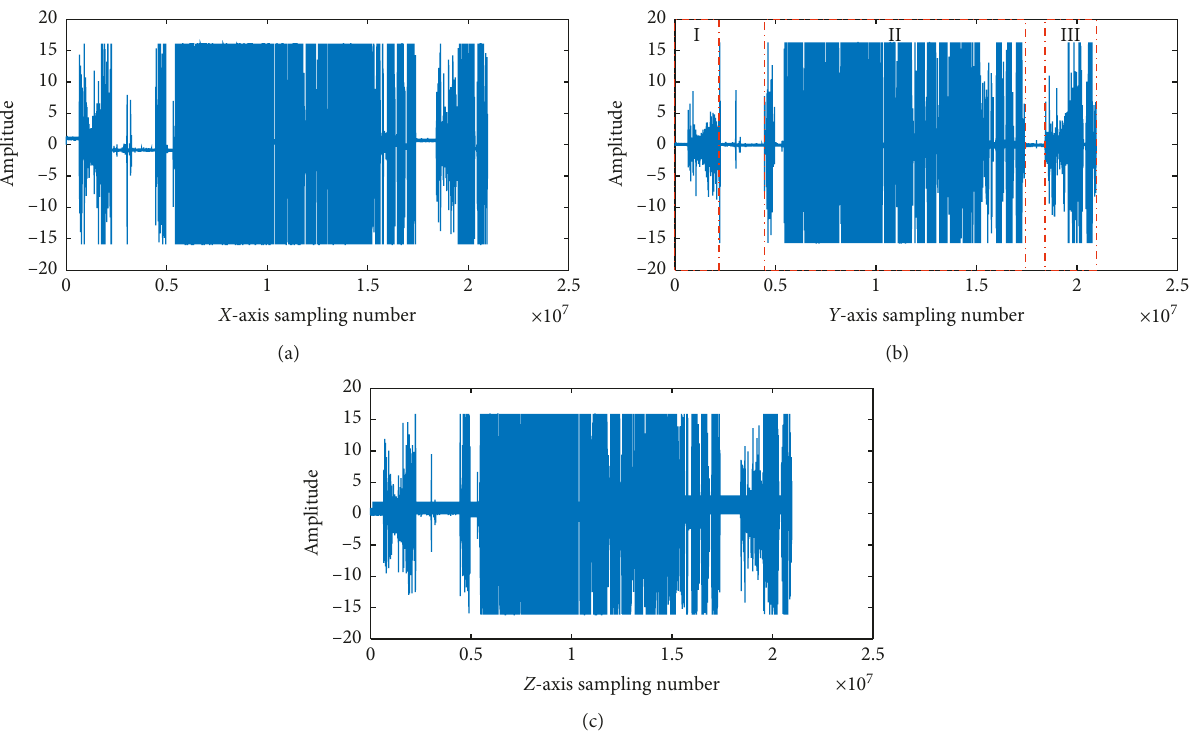
Figure 13: Typical recorded vibration signal: (a) signal in x -axis; (b) signal in y -axis; (c) signal in z